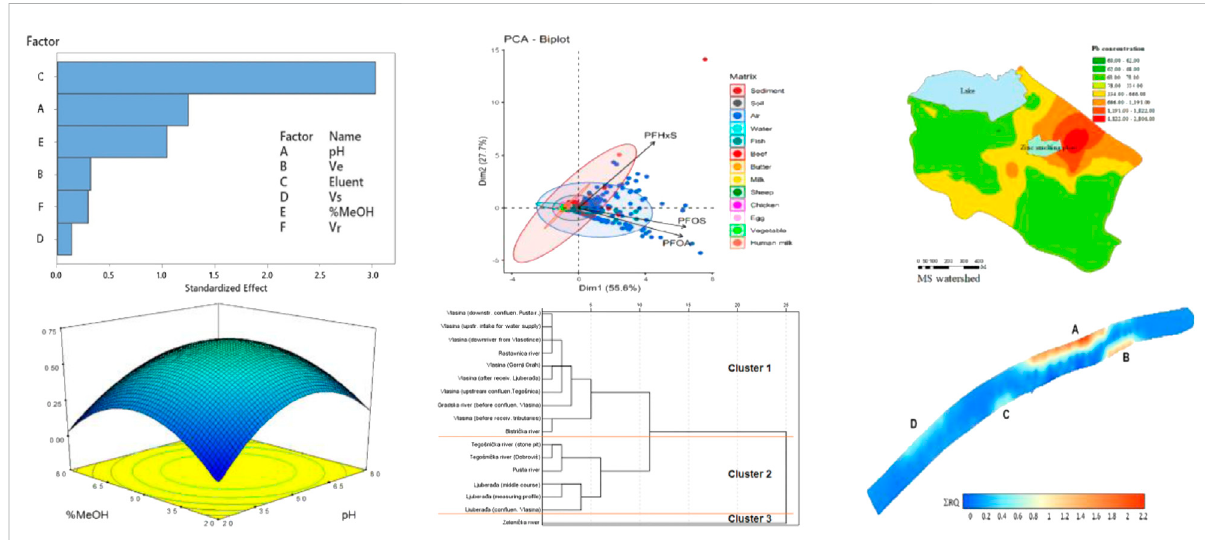
FIGURE 1 Some of the fi gures from the research topics. (A) Pareto chart from the screening Plackett-Burman experimental design. (B) Response surface optimization graph. (C) PCA-Biplot. (D) Dendrogram from HCA. (E) GIS map of soil. (F) GIS map of